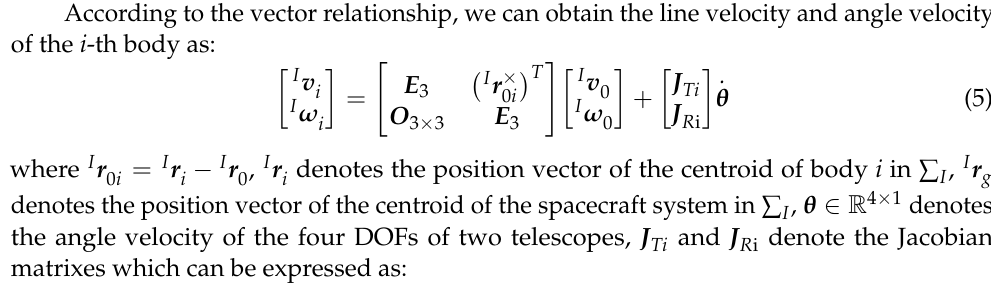
denotes the rotation center of telescope 2